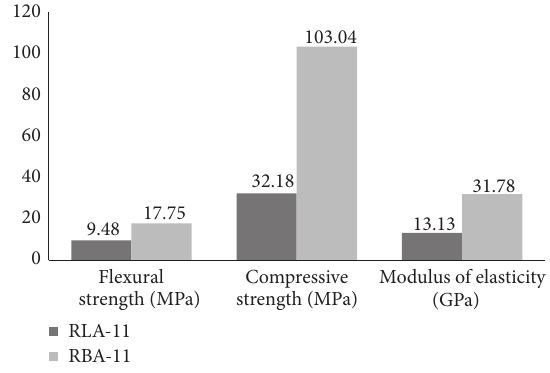
Figure 8: Comparison of the obtained mechanical properties from RLA-11 and RBA-11.